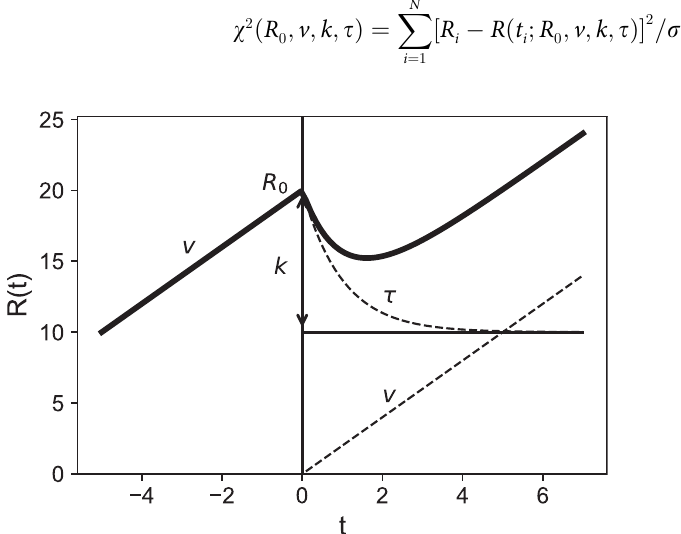
Fig 1. Illustration of the analytical model describing the tumor radial evolution. Before RT ( t < 0), the radius evolves linearly with the asymptotic speed v and reaches R 0 at t = 0. Then it becomes the sum of an exponential decay of amplitude R 0 − k and characteristic time τ (death term) and a linear vt